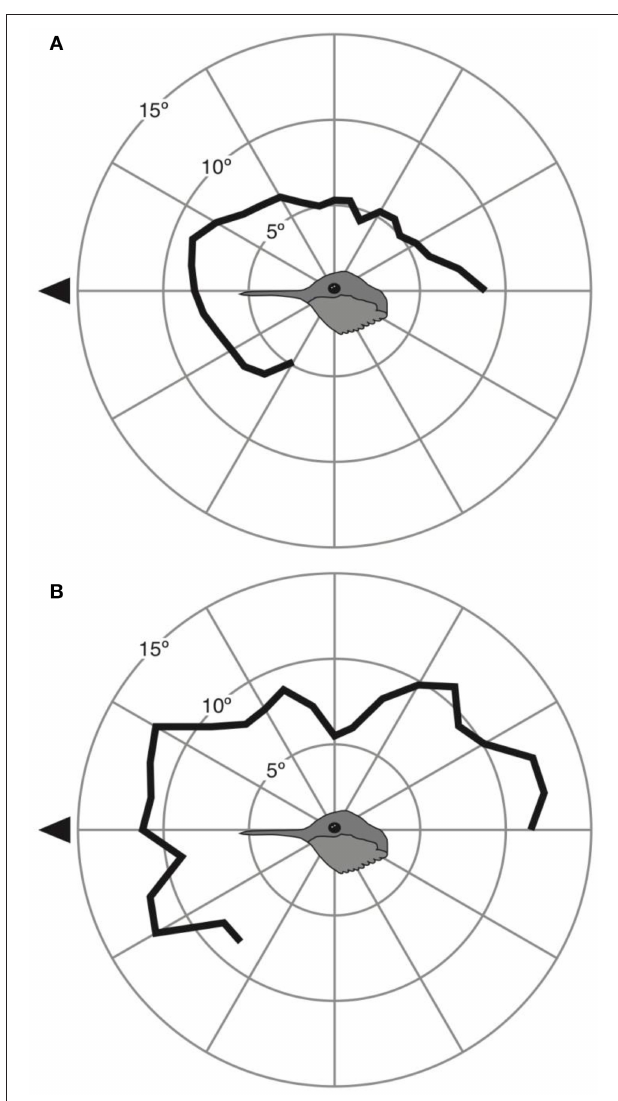
FIGURE 3 | Eye movement magnitude at different elevations around the head for Anna’s (A) and Rufous (B) hummingbirds. Black triangle indicates the direction of the